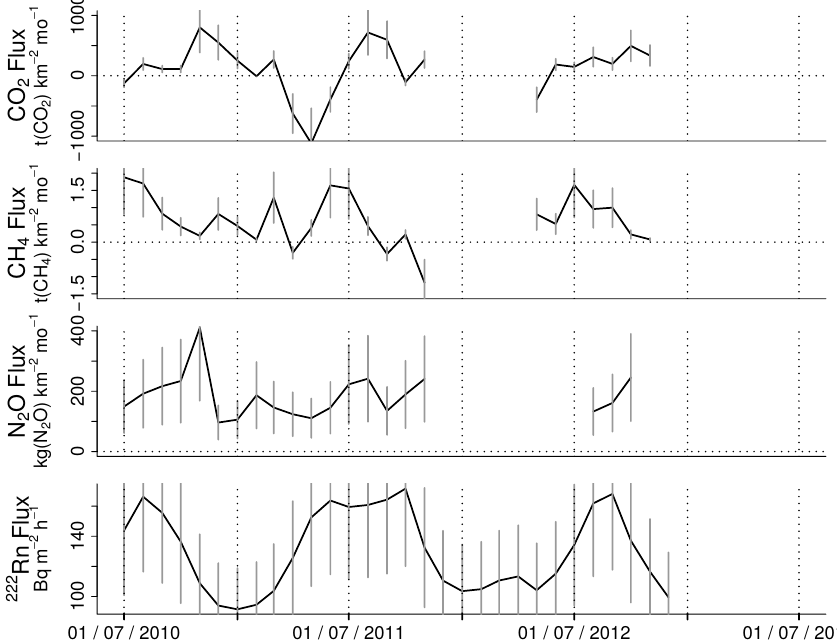
Figure 8. Monthly CO 2 , CH 4 and N 2 O fluxes at the Puy de Dôme station derived from the radon tracer method. The last panel presents the hourly 222 Rn exhalation rate (U. Karstens and I. Levin, personal communication, 2014). The vertical grey lines are the respective flux uncertainties. Table 7. Summary of CH 4 and N 2 O flux estimations and their respective uncertainties over western Europe using the RTM (this study; Biraud et al., 2000; Schmidt et al., 2001; van der Laan et al., 2009a; Lopez et al., 2012; and regional emission inventory of CITEPA).